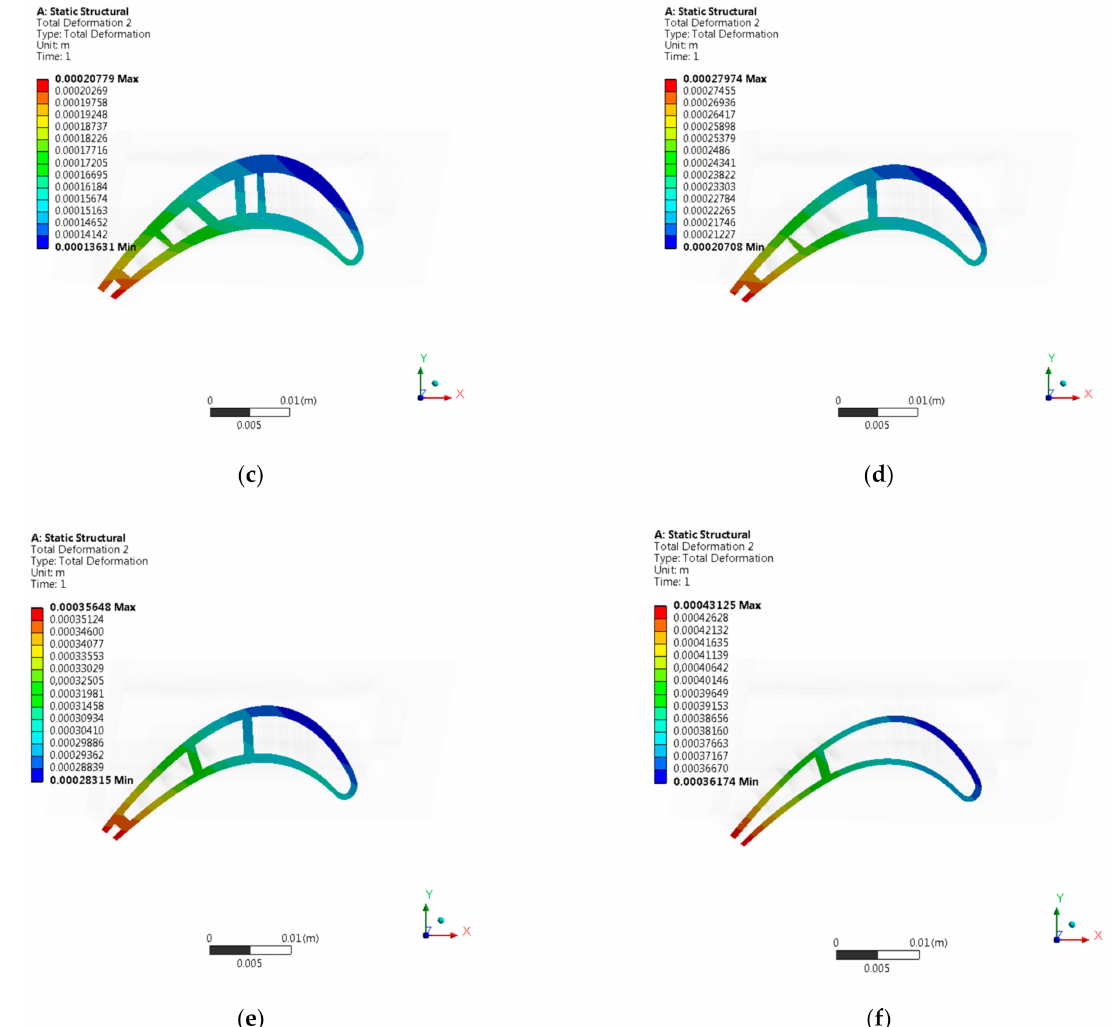
Figure 9. Position of the specific sections of the HPT blade ( a ); displacement [m] distribution in specific sections of the HPT blade: ( b ) Section 1; ( c ) Section 2; ( d ) Section 3; ( e ) Section 4; ( f ) Section 5.